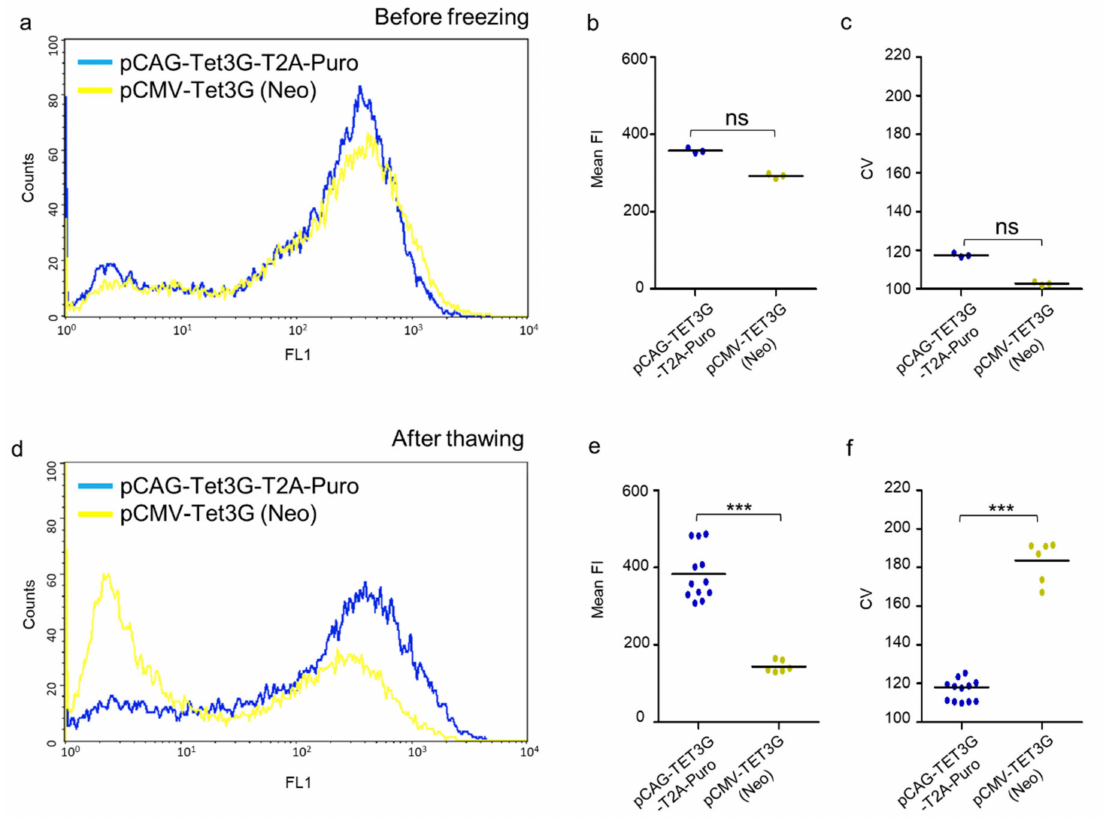
Figure 3. Characteristics of the transgene expression obtained with the new Tet-On3G-T2A-Puro system. The parameters of the transgene expression corresponding to the transactivator activity were measured by flow cytometry for both inducible HEK293 cell lines generated with redesigned TetOn-3G-T2A-Puro and original Tet-On3G systems before cryopreservation ( a , b , c ) and after long-term cryopreservation (>6 months), thawing, and cultivation ( d , e , f ). The stable cell line created with the new variant of the system shows twice higher mean fluorescence intensity of GFP transgene and a homogenous profile of its expression after the freezing–thawing cycle in comparison to the cell line established with the standard system. This is displayed on flow cytometry histograms ( a,d ) and reflected in the mean fluorescence intensity (FI) ( b,e ) and the coefficient of variation (CV) measurements ( c,f ) presented in the plots. Statistical significance of differences between both stable cell lines was calculated using the Mann–Whitney test and is represented by asterisks: *** p < 0.001; ns—not